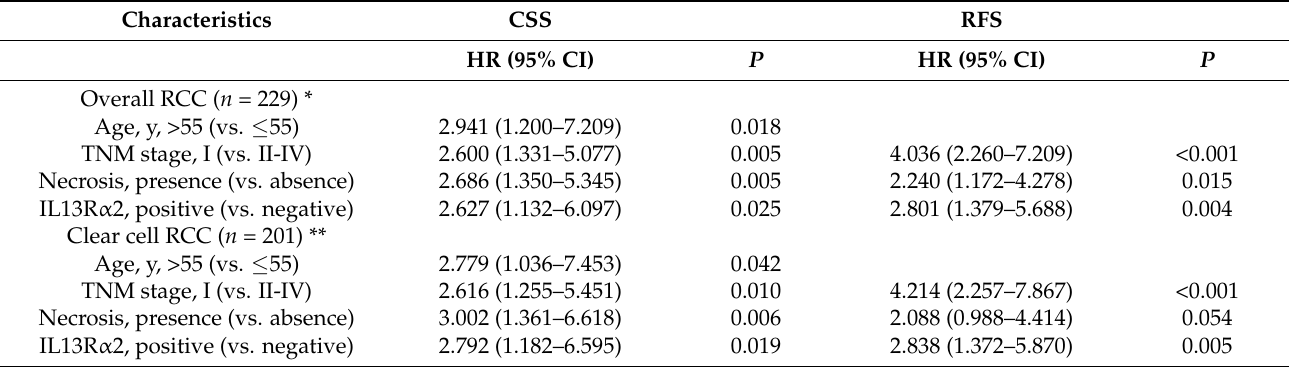
Table 3. Multivariate Cox regression analysis of cancer-specific survival and relapse-free survival in renal cell carcinoma patients. Characteristics